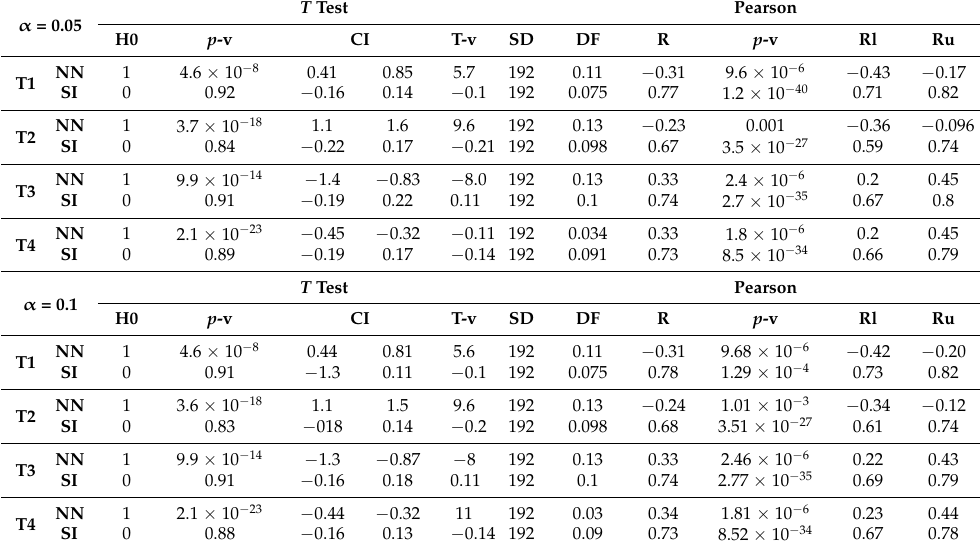
Table 9. Statistical summary of fitting and comparisons procedure ( p -v— p value, T-v—T value, Rl—Person index lower bound, and Ru—Person index upper bound).